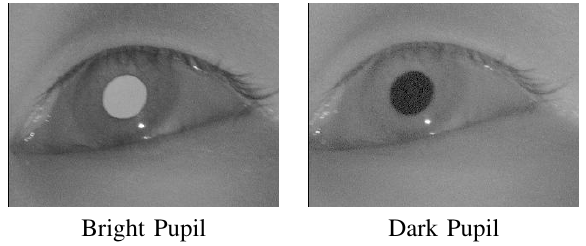
Fig. 1. Bright and dark pupil images generated by the dual light source eye